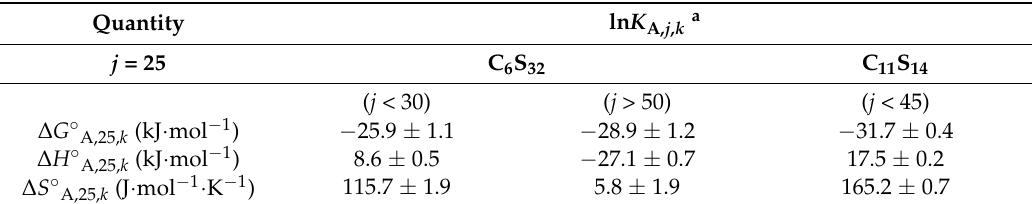
Table 2. Thermodynamic quantities of ln K A, j , k from C n S m polymers ( T = 25 ◦